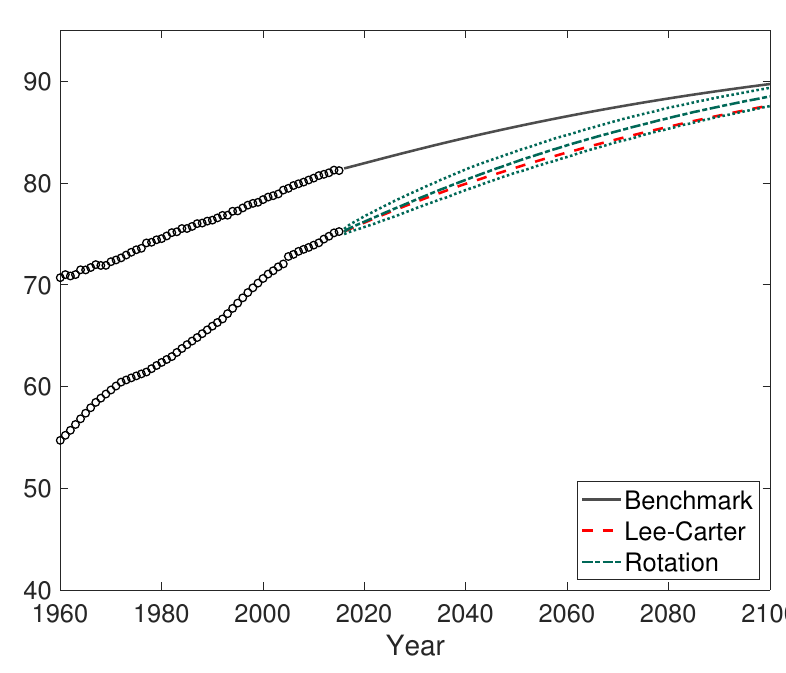
Figure A5. The average projected life expectancy of the benchmark countries and Brazil using the rotation algorithm and the independent Lee–Carter model.